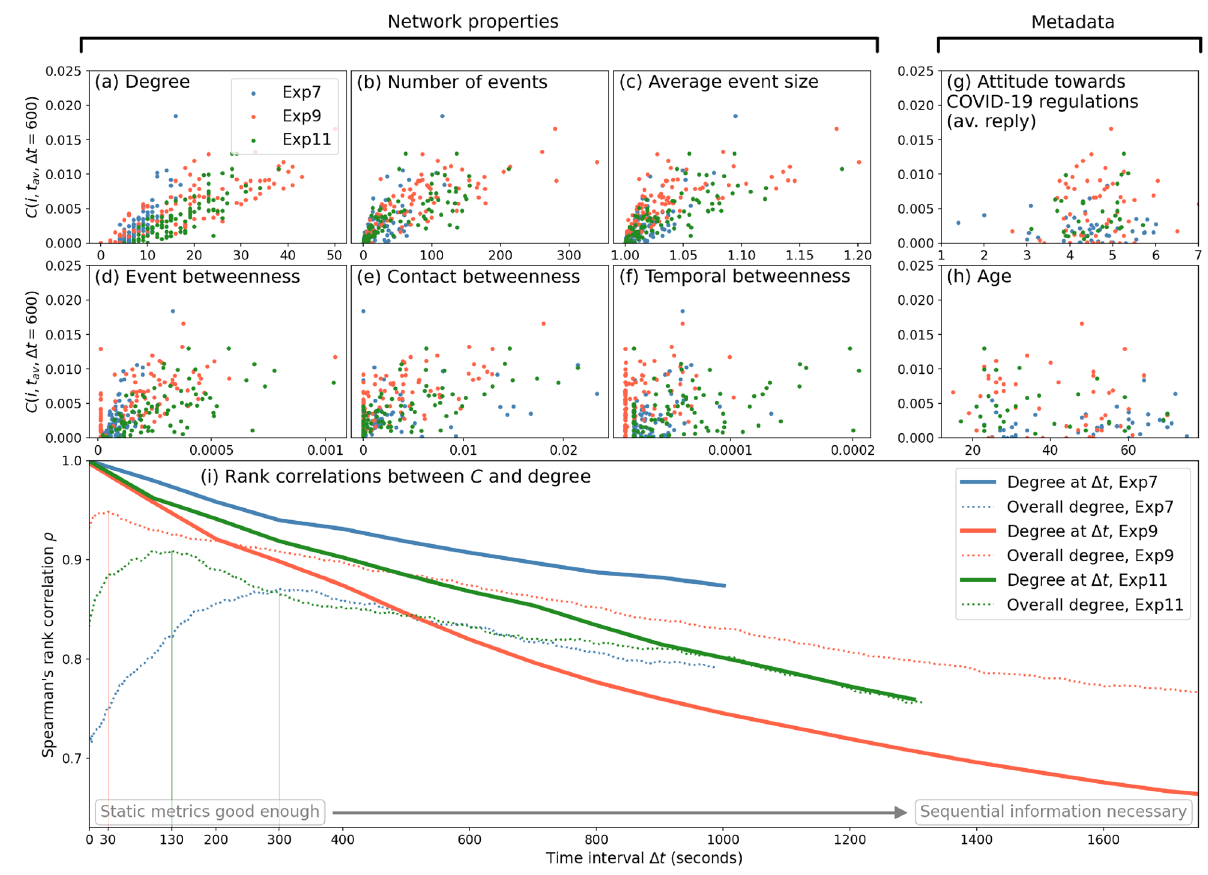
Figure 4. Panels (a–f) : Relation between agent’s impact on C and various network properties. Different colors denote different experiments. Panels (g,h) : Same as in panels ( a – f ), but for two metadata metrics: the inferred attitude of the agent with respect to COVID-19 measures based on questionnaire data, and the agent’s age. Panel (i) : Spearman’s rank correlation coefficients between contact degree and Ci for different values of (cid:31) t for each of the three experiments. Thick lines indicate the correlation coefficients when using the average degrees of the agents when looking at interval sizes (cid:31) t (as marked by the horizontal axis), while the dotted lines use the overall degree, independent of (cid:31) t . Per experiment, (cid:31) t values of up to half of the experiment’s total time interval are used, to keep enough initialization times t to average